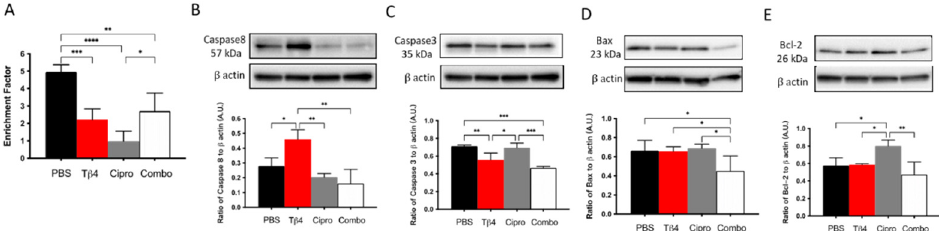
Figure 7. Apoptotic activity was determined using select markers as detected at the protein level. Cytoplasmic DNA fragments ( A ), caspase-8 ( B ), caspase-3 ( C ), Bax ( D ), and and Bcl-2 ( E ) were as-